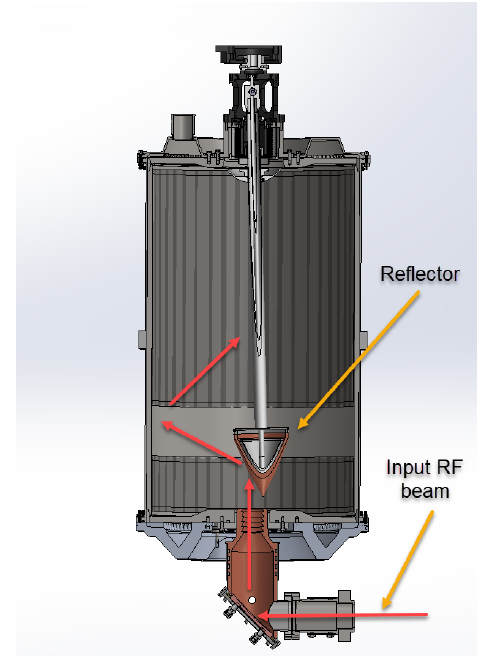
Fig. 2. Conceptual mechanical design